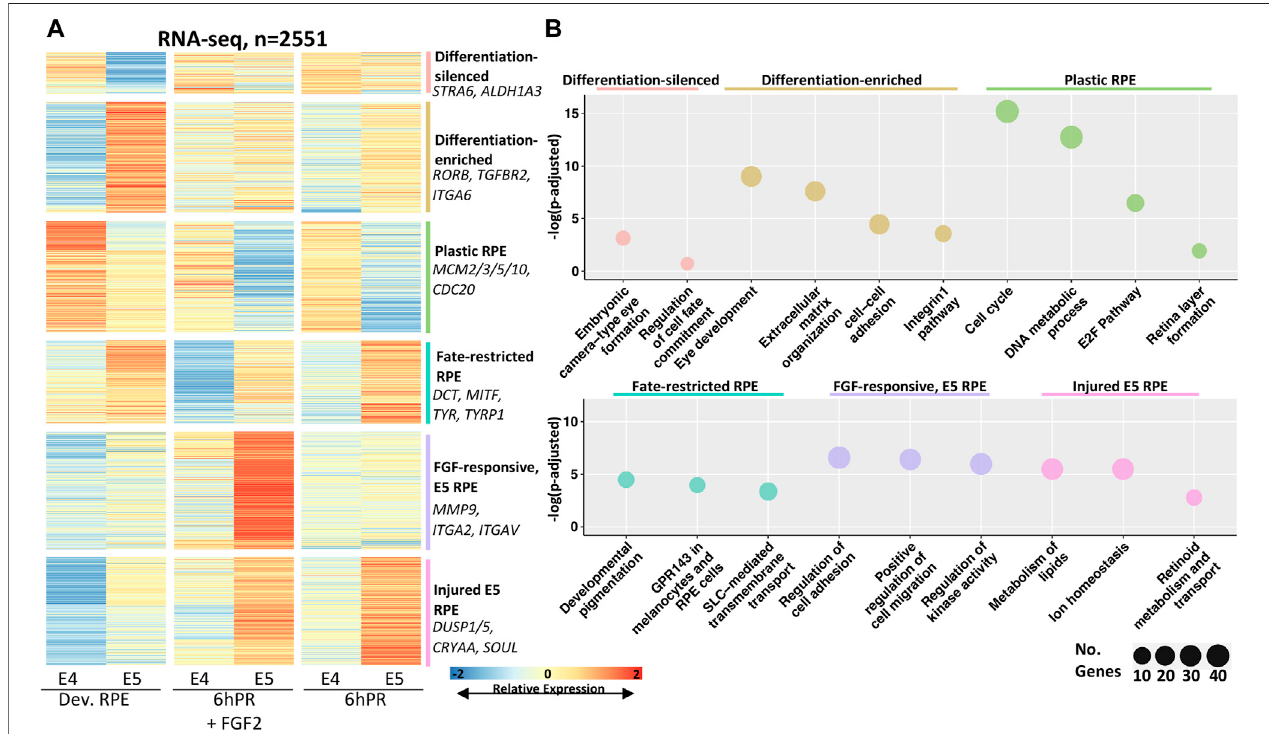
FIGURE 2 | Clustering of differentially expressed genes reveals expression programs associated with RPE commitment and reprogramming. (A) Af fi nity propagationclusteringwasperformedonallgenesthataredifferentiallyexpressedacrosstheE4toE5windowbythecriteria|LFC| ≥ 1andadj. p -value ≤ 0.05( n =2551), resultinginsixclusters.Keygenesaresummarizedontherightofheatmap.Theheatmapintensitydisplaysrow-normalizedgenecounts. (B) Bubblechartsdisplayselect gene ontology terms associated with each cluster. Adj. p -value is plotted on y -axis and the bubble size is proportional to number of terms identi fi ed in the analysis.